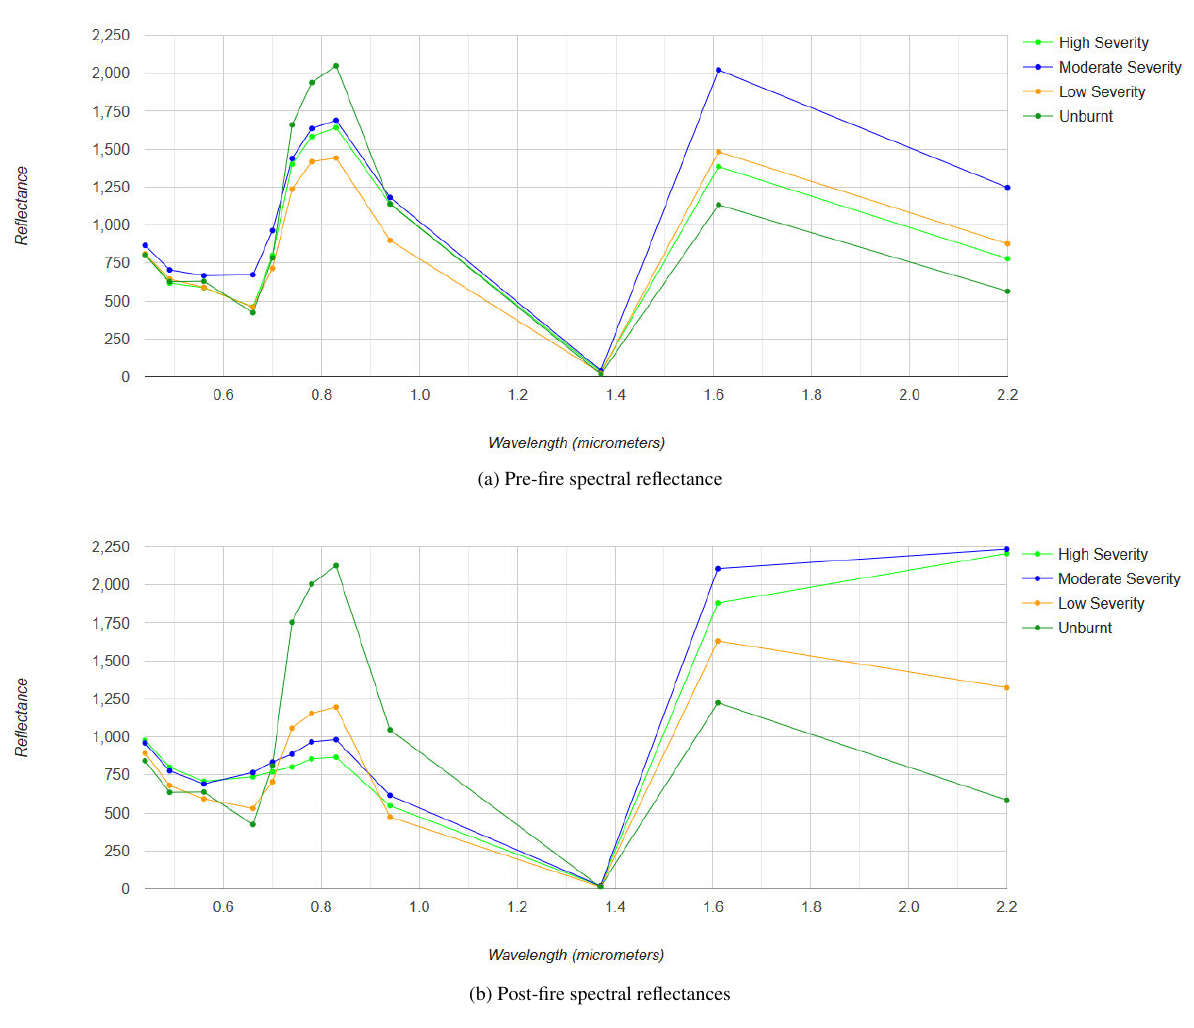
Figure 3. Spectral reflectance of pre- and post-fire images. Table 4. Comparison of detected burnt areas versus the ones re- ported in hectares